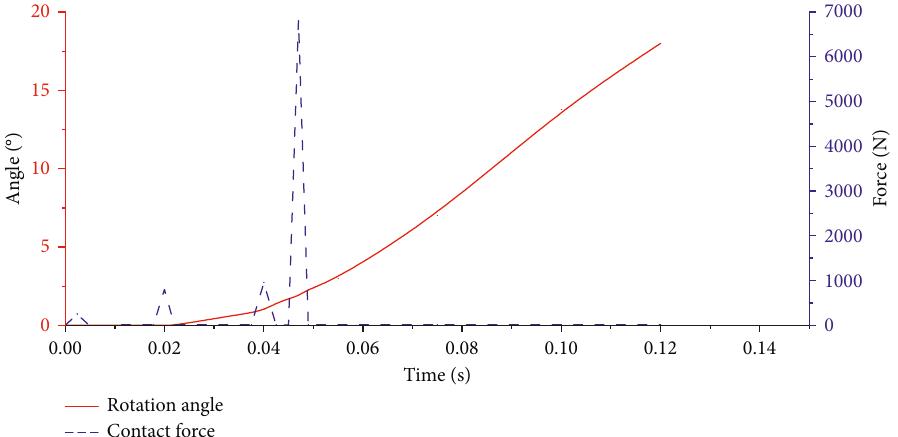
Figure 12: The change curve of the angle between the axis of the output flange and the auxiliary line.